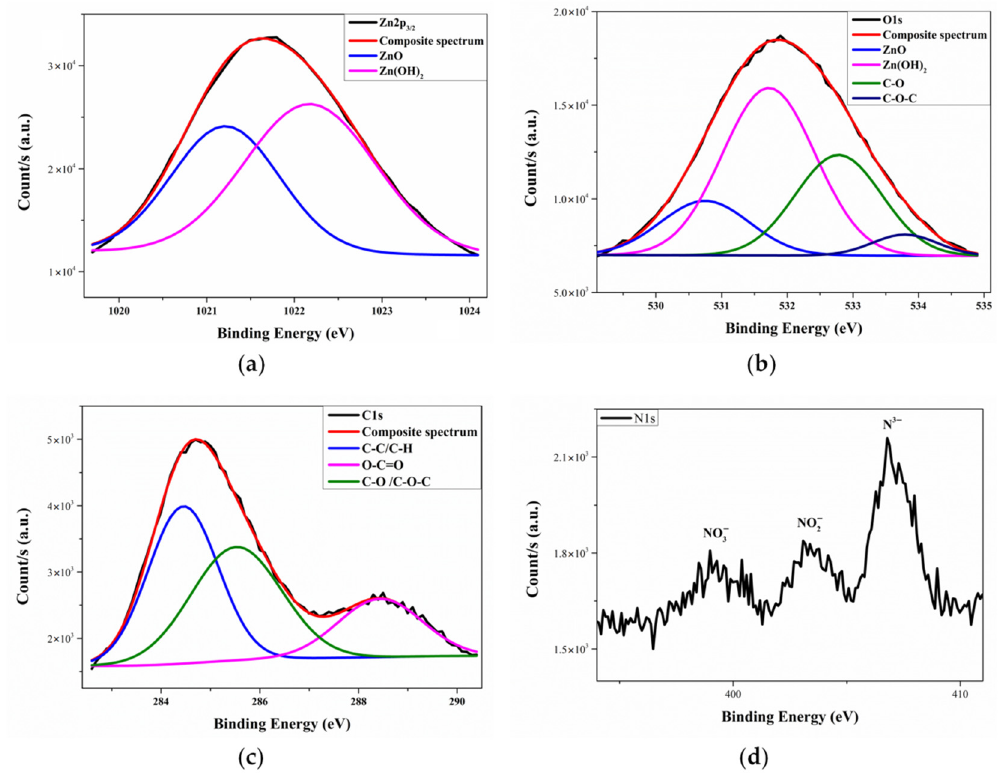
Figure 7. High-resolution XPS spectra of ( a ) Zn2p 3/2 , ( b ) O1s, ( c ) C1s, ( d ) N1s. Table 1. Surface elemental composition, peak position, and atomic percentage of the coated wood surface determined using XPS analysis.